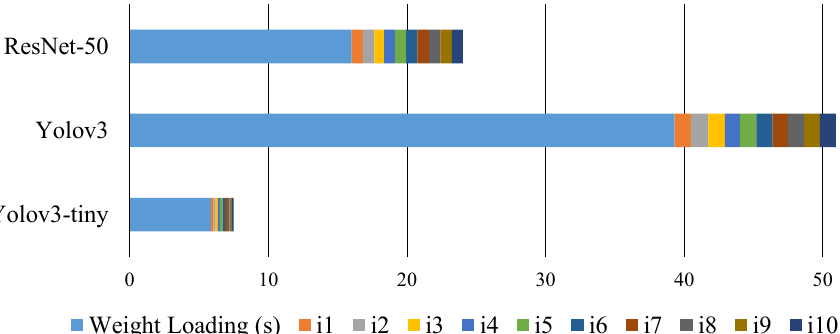
Figure 8. The detailed time decomposition of various NN models using ten images.